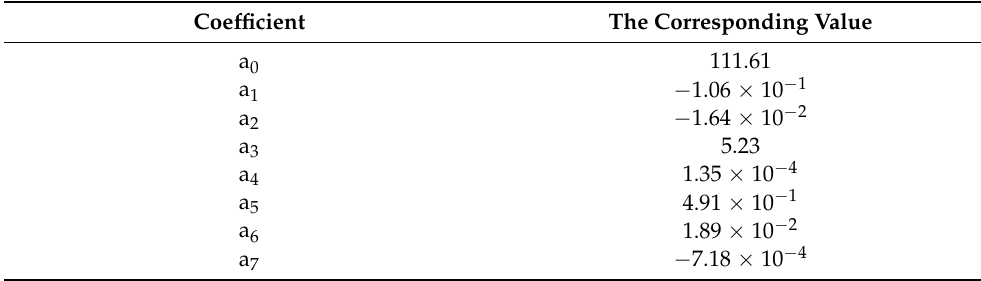
Table 7. The regression equation coefficients for relative